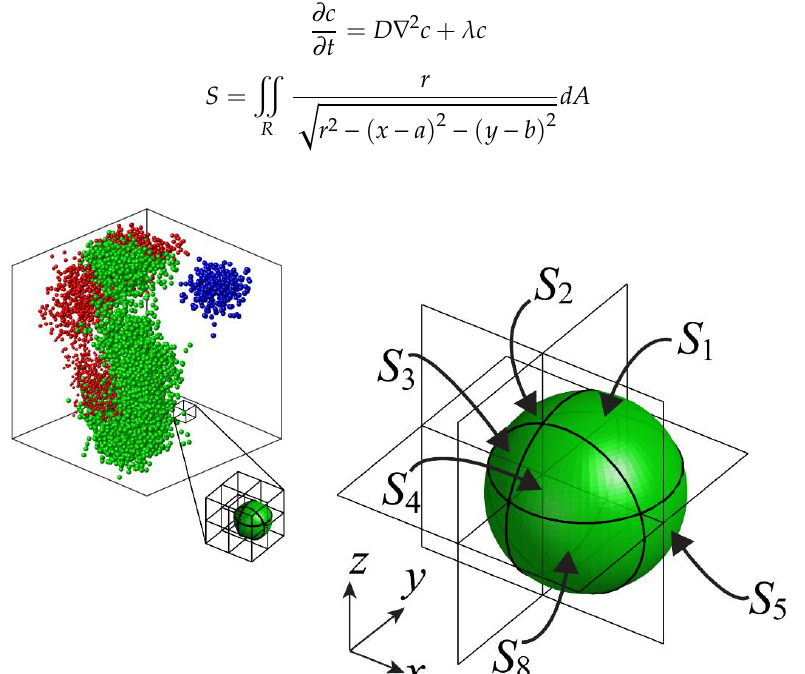
Figure 1. Schematic diagram of an agent-based model for 3D cell proliferation ( left ) and a spherical agent representing a cell overlapping with surrounding finite volumes ( right ). There are more than 4600 agents in the snapshot of a simulation ( left ). A small zoomed-in view of a cell with surrounding finite volumes (rectangular boxes) is shown in the middle. A further zoomed-in view of the cell is displayed on the right. When the agent’s diameter is smaller than the edge of the rectangular box, the agent can overlap with up to eight finite volumes. S 1 , S 2 , ... , and S 8 are surface areas that overlap eight finite volumes.